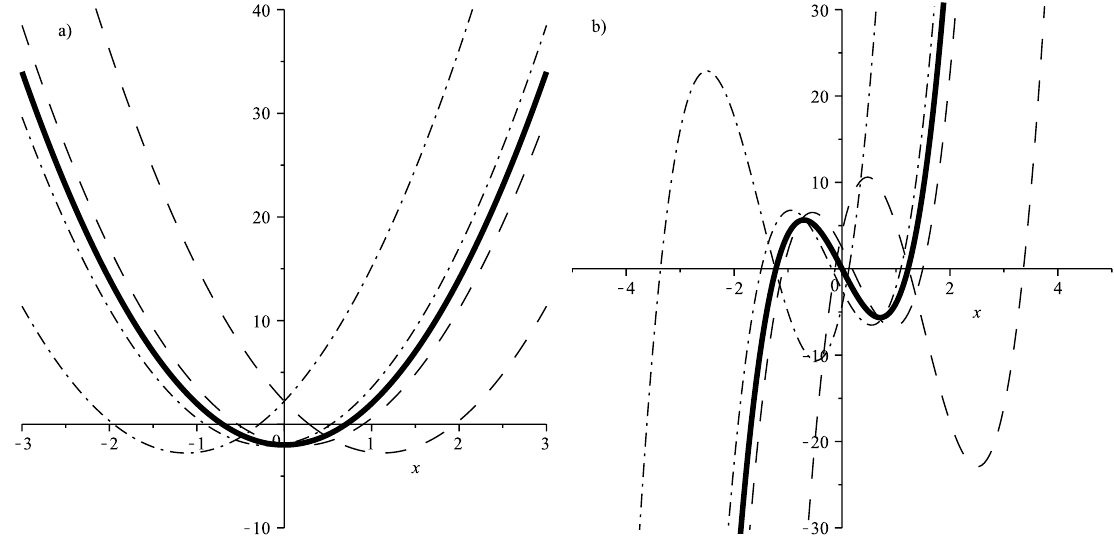
(cid:17) (cid:16) x √ , N . Panel ( a ) depicts n = 2 and ; ν N N